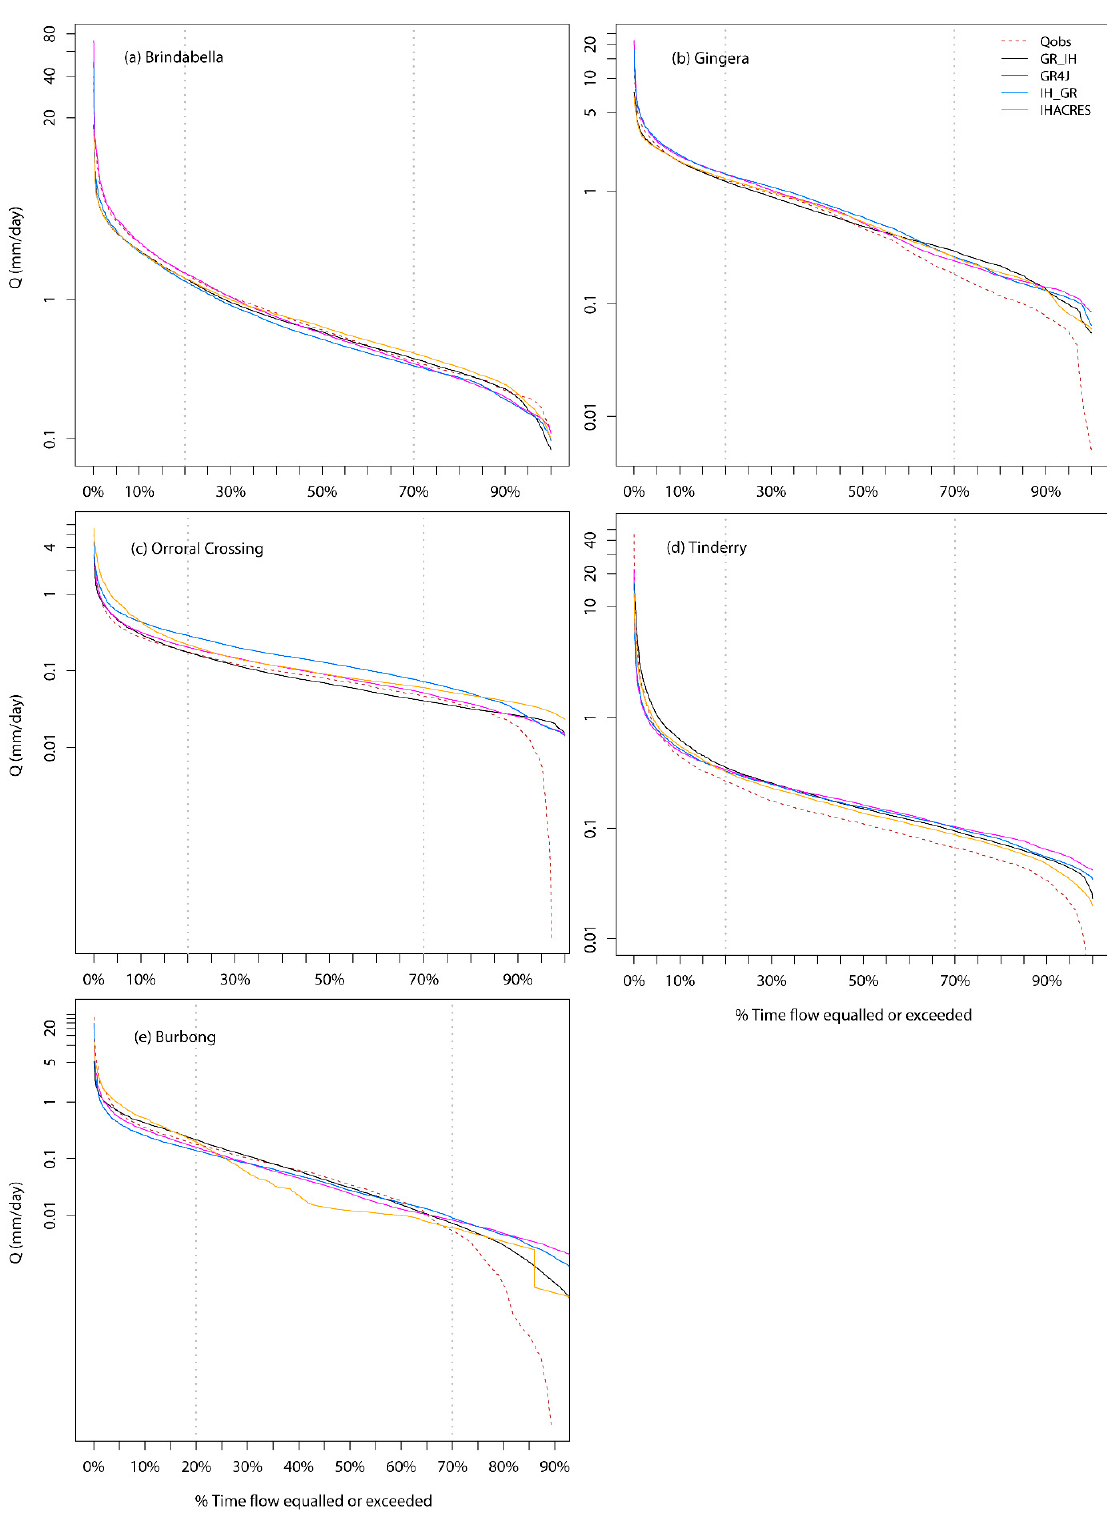
Figure 5. Comparison of the flow duration curves of the four rainfall–runoff models with respect to the NSElog objective function: ( a ) validation of the 1970s with the calibration of the 2000s for the Brindabella (wet) catchment, ( b ) validation of the 1980s with the calibration of the 1970s for the Gingera (wet) catchment, ( c ) validation of the 2000s with the calibration of the 1980s for the Orroral Crossing (intermediate) catchment, ( d ) validation of the 1990s with the calibration of the 1970s for the Tinderry (dry) catchment, and ( e ) validation of the 1980s with the calibration of the 1990s for the Burbong (dry) catchment.